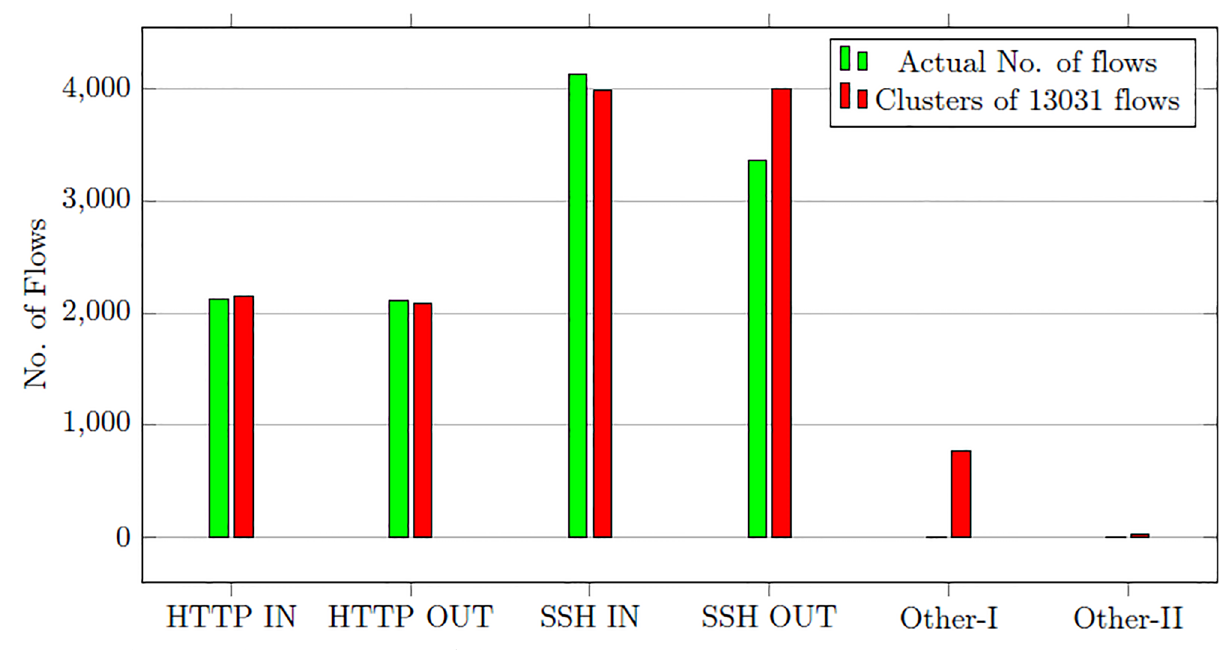
Fig 6. SOM clustering results comparison—Sperotto’s dataset.